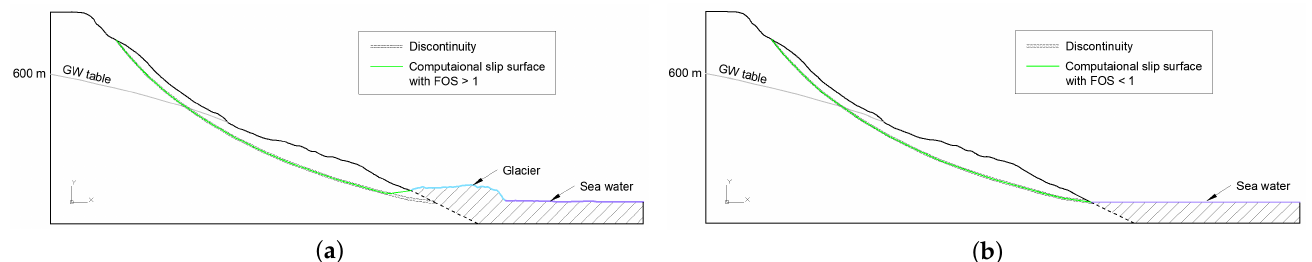
Figure 12. The locations of the weak layer and resulting computational slip surface with the initial groundwater table at 600 m. ( a ), with the glacier at the toe based on the 2014 slope profile. ( b ) without the glacier. Table 11. Safety factors for the 4 cases (a1 and a2 for the weak layer in the case of Set 1, b1 and b2 for the weak layer in the case of Set 2, see Table 8), with and without the glacier at the toe. a1 a2 b1 b2 With glacier 1.022 Without glacier 0.952 0.934 0.985